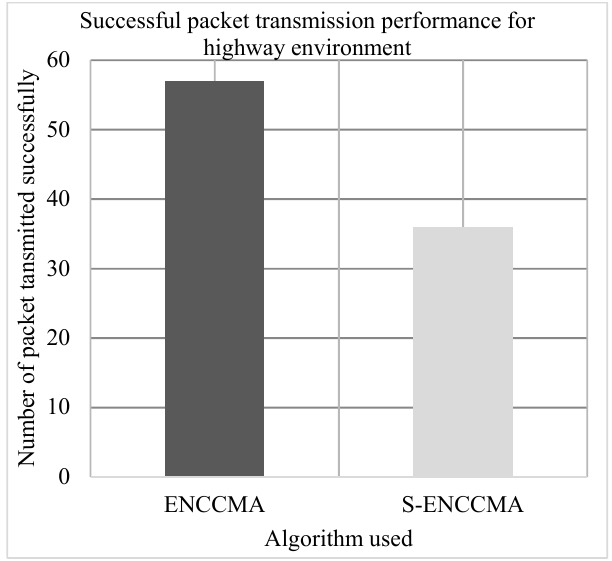
Figure 7. Successful packet transmission performance achieved for a highway environment. Successful packet transmission performance for rural environment